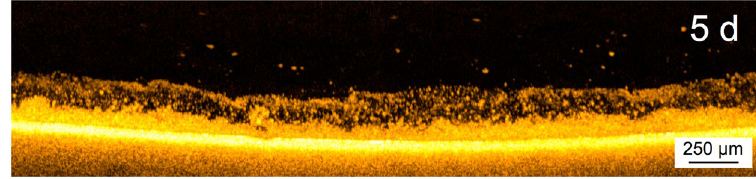
Figure 7. Double layered morphology observed on 5 d of GD-SMBR operation.